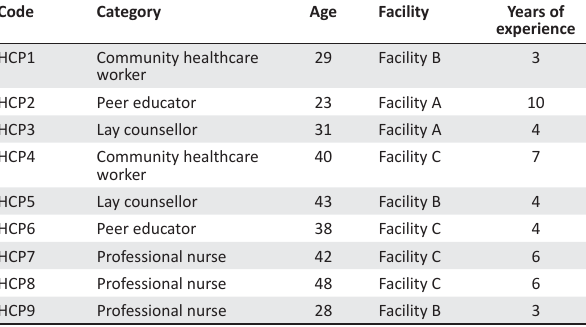
TABLE 2: Participants: Healthcare workers. Code Category